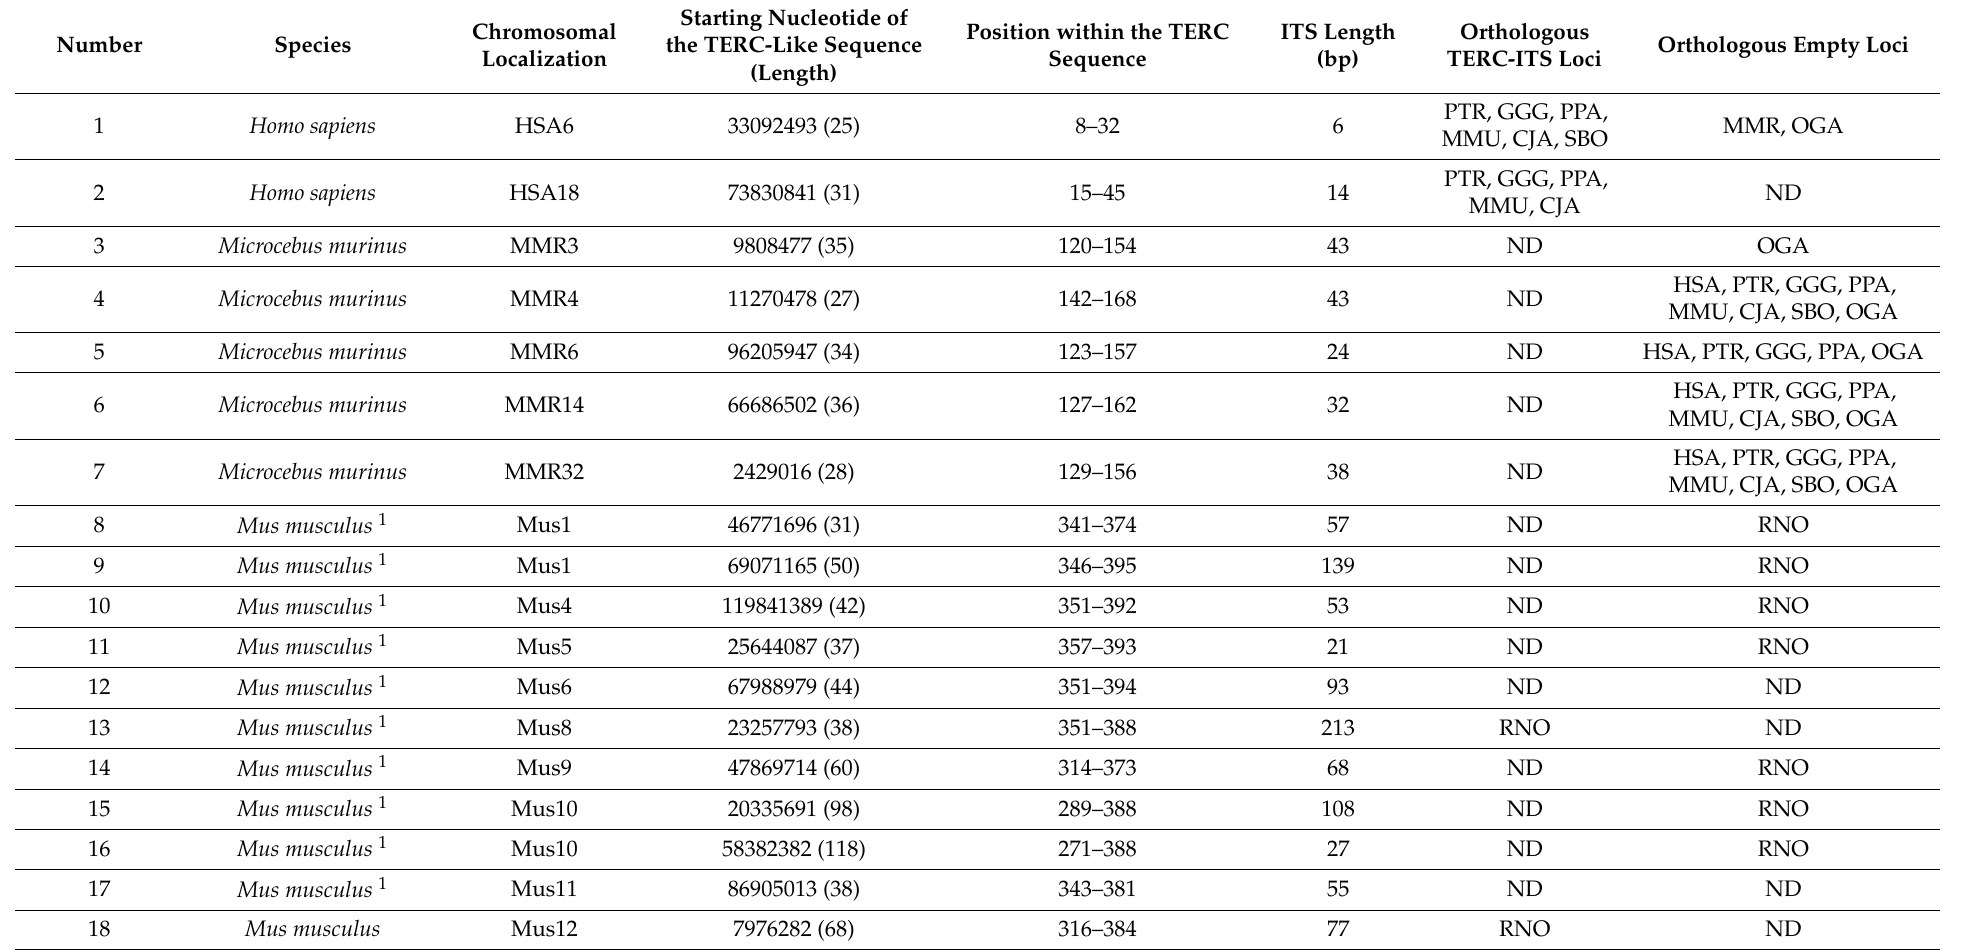
Table 1. Vertebrate TERC-ITS